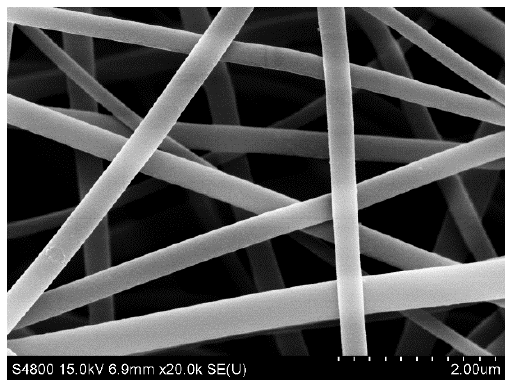
Figure 2. FESEM images of PI nanofibers.